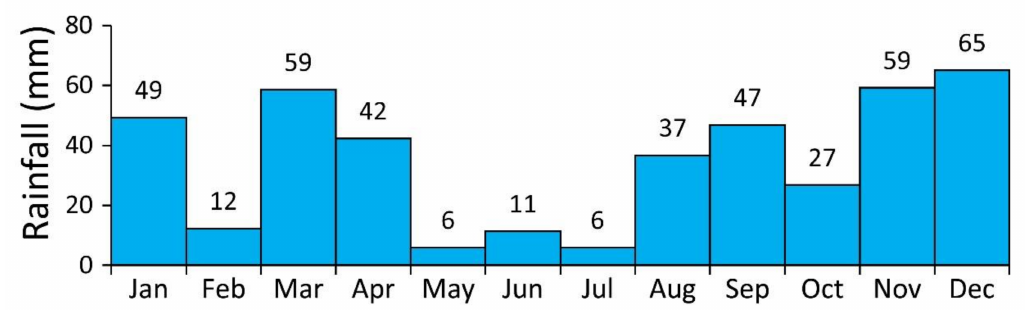
Figure 1. Mean monthly rainfall data recorded at the Cocentaina meteorological station during the study period